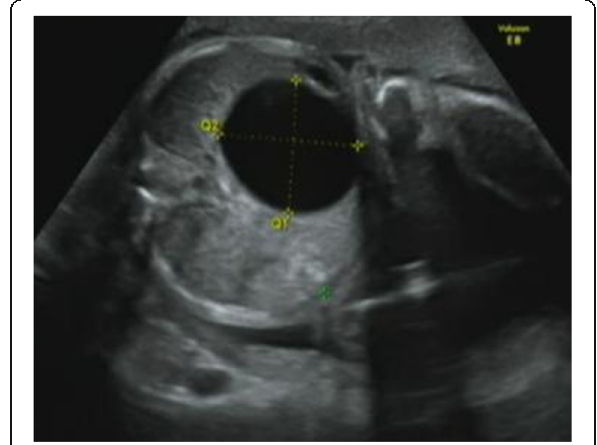
Fig. 1 Antenatal ultrasonographic findings at 16 weeks gestation. A cystic lesion, 37 × 40 mm in size, was observed in the hepatic